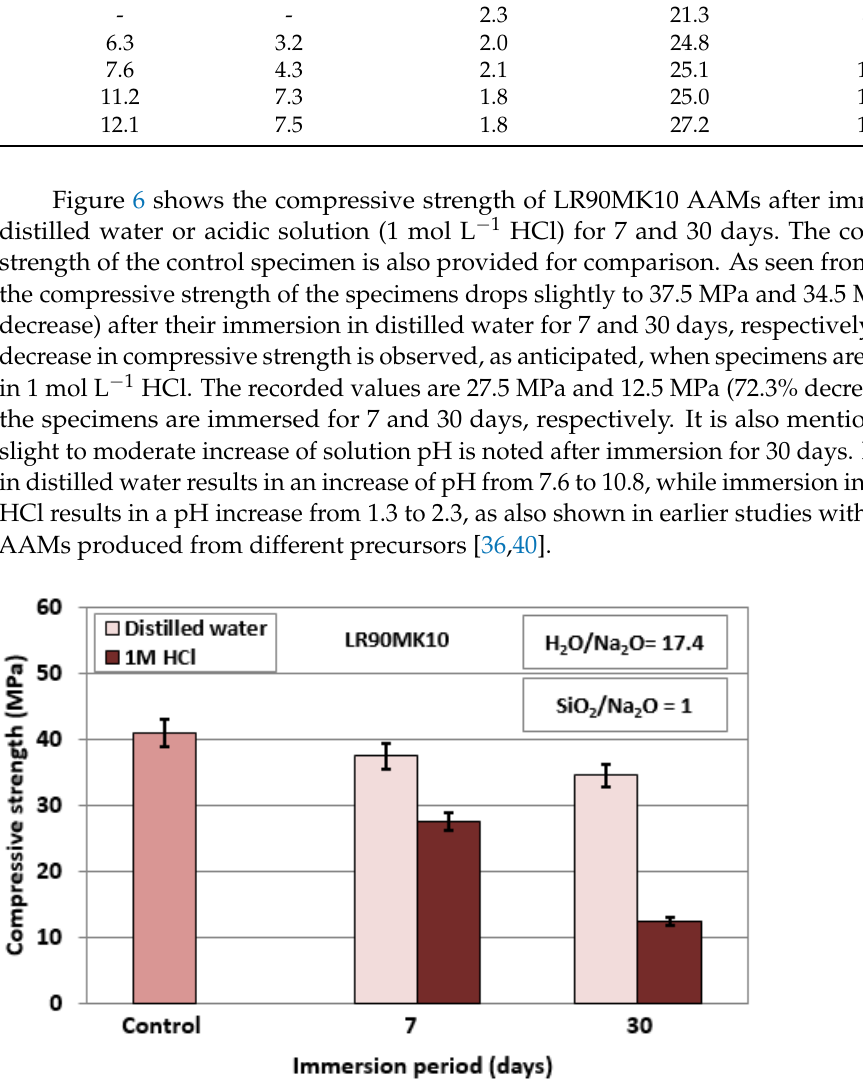
Figure 6. Compressive strength of LR90MK10 AAMs after immersion in distilled water and 1 mol L − 1 HCl for 7 and 30 days; synthesis conditions: pre-curing time, 4 h; curing period, 24 h; curing temperature, 80 ◦ C; ageing period, 7 days; error bars indicate the standard deviation of measurements obtained from three specimens.